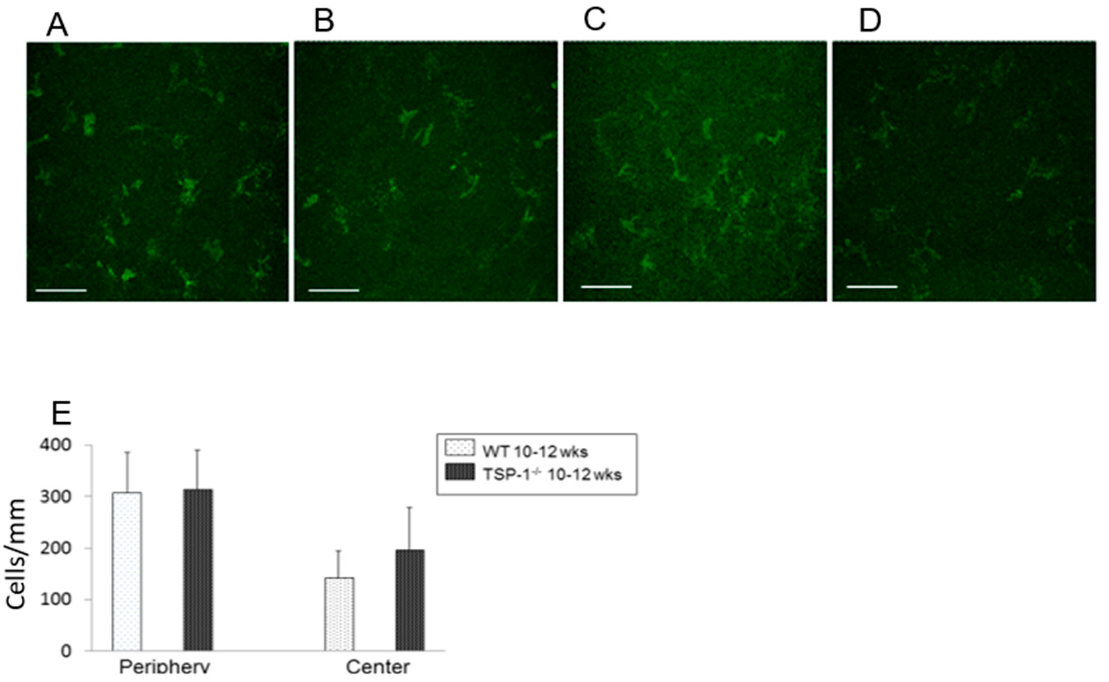
Figure 3. Comparison of the number of monocytes in WT and TSP-1 − / − mouse corneas through analysis of CD11b+ cells ( E ). CD11b+ cells were present in young WT peripheral areas ( A ), young WT central areas ( B ), young TSP-1 − / − peripheral areas ( C ), and young central areas ( D ). The number of cells/mm was analyzed for each condition and are presented in ( E ). n = 3. Scale bar represents 50 µ m. 2.4. Number of Corneal Nerves Was Decreased in TSP-1 − / − Compared to WT Mice When Analyzed by In Vivo Confocal Microscopy